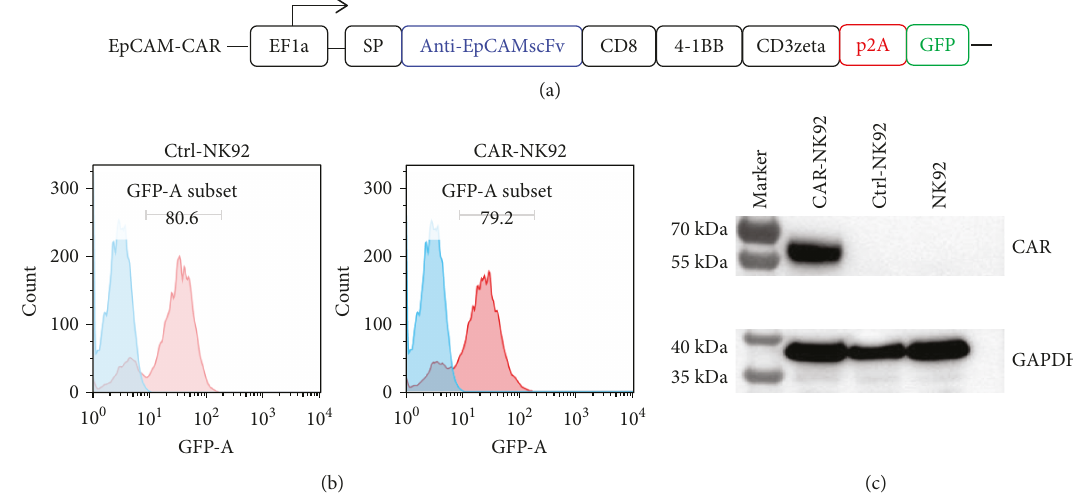
Figure 1: Generation and characterization of EpCAM-speci fi c CAR-NK-92 cells. (a) Structure diagram of EpCAM-speci fi c CAR. EF1 α , promoter; SP, signal peptide; scFv, single-chain variable fragment. (b) Transduction e ffi ciency of lentivirus in NK-92 cells. NK-92 cells were transduced with empty lentivirus vector (Ctrl-NK-92) or lentivirus containing the EpCAM-speci fi c CAR encoding sequence (CAR-NK-92) and sorted by a FACS machine with a GFP marker. The GFP-positive rate of transduced NK-92 cells after sorting is shown. (c) Western blot analysis of the CAR expression in NK-92 cells with a monoclonal anti-human CD3 ζ antibody. Glyceraldehyde-3- phosphate dehydrogenase (GAPDH) was also detected as an internal